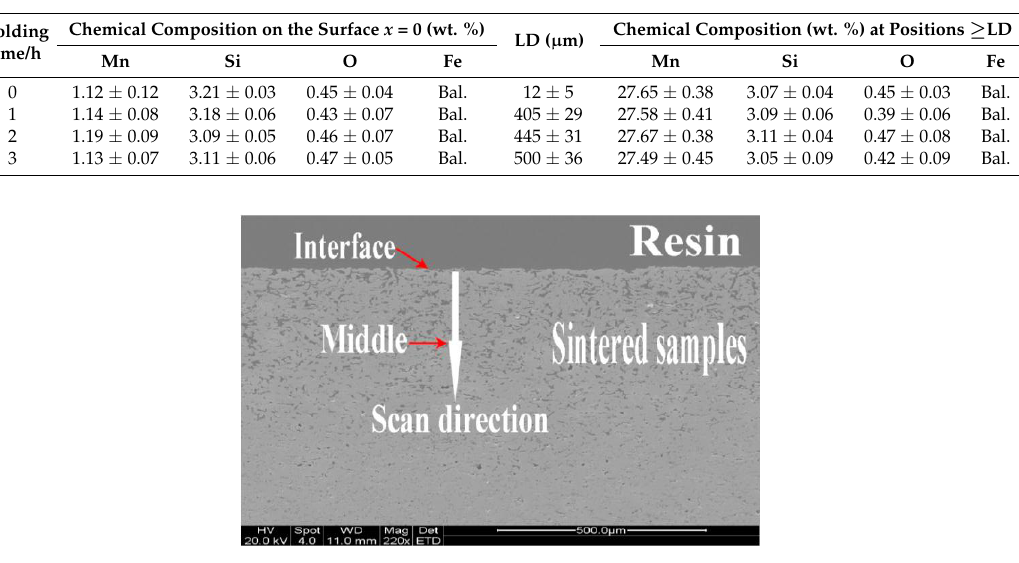
Figure 3. Morphologies of the cross-section of the MM Fe-28Mn-3Si alloys sintered at 1200 °C for 1 h.